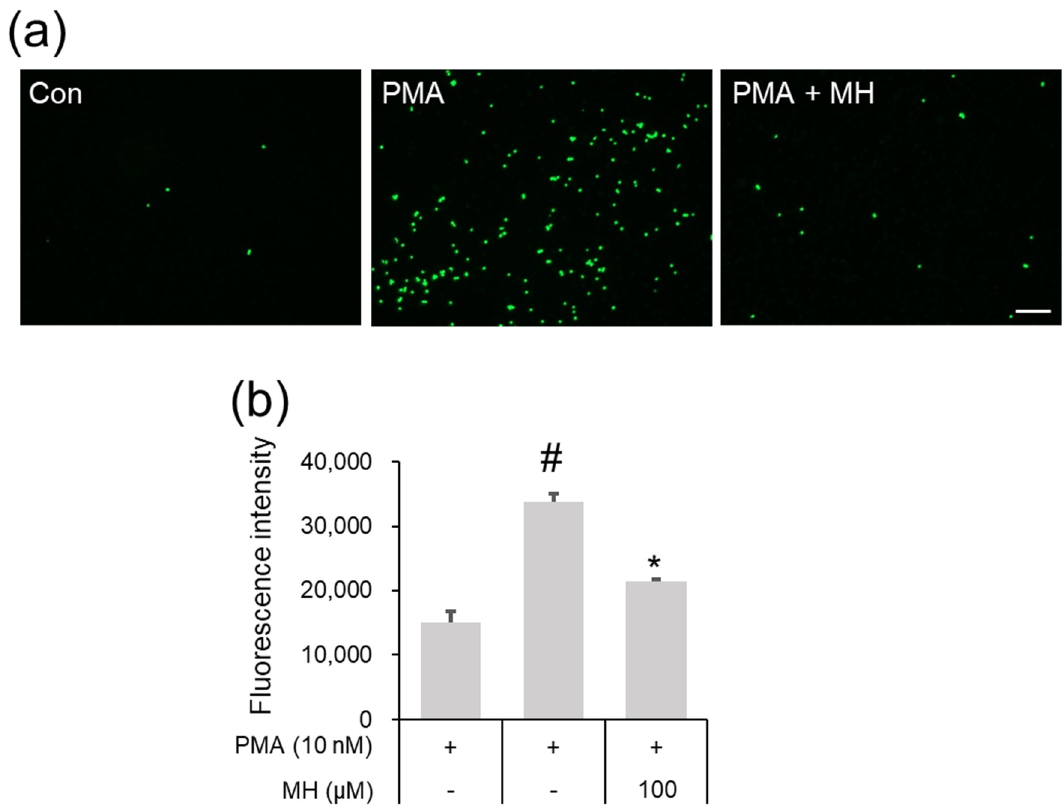
Figure 3. Effect of MH on the adhesion of A549 and EOL − 1 cells. A549 cells were treated with 100 µ M MH 1 h prior to incubation with 10 nM PMA for 5 h. Subsequently, EOL − 1 cells stained with calcein AM were incubated with A549 cells for 1 h. ( a ) Green fluorescence, which indicated A549 and EOL − 1 cell adhesion, was observed using fluorescence microscopy (magnification, ×100; scale bar, 100 μ M). ( b ) The levels of EOL − 1 cells adhering to A549 cells were quantified by detecting the fluorescence intensity. Data are expressed as the mean ± SD (n = 3) ( # p < 0.05 for comparison with control; * p < 0.05 for comparison with 10 nM PMA).